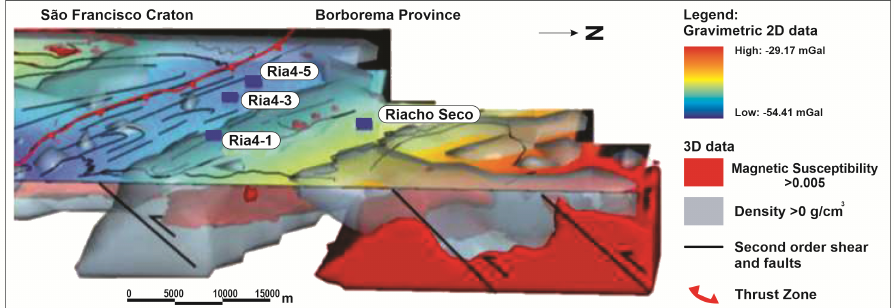
Figure 13. The MVI magnetic gravimetric inversions in the region of the Riacho do Pontal Copper District. Ria4-1, Ria4-3, Ria4-5 and Riacho Seco are the major occurrences at Riacho do Pontal Copper District. In the region of the Riacho Seco Deposit and Riacho do Pontal prospects, the magnetization and density anomalies are weaker (SI > 0.005 and density > 0 g / cm 3 ) and deeper ( > 1.5